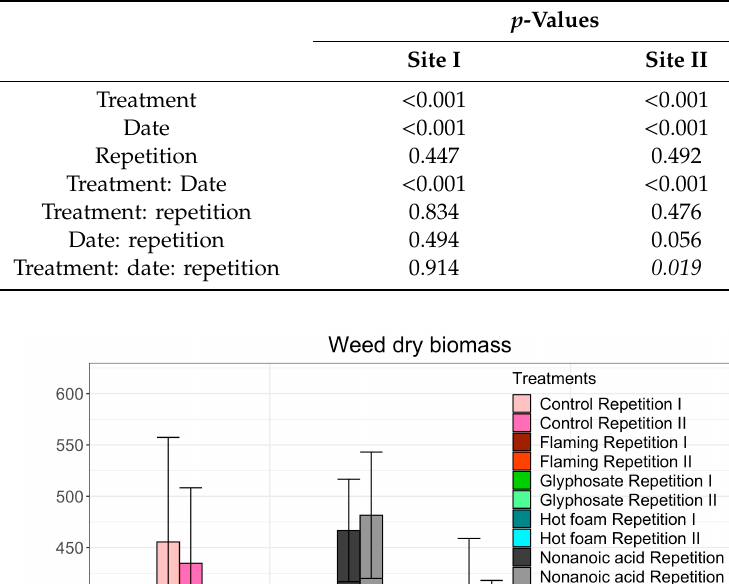
Table 4. Weed regrowth analysis of variance resulting from the linear model, where weed coverage was a ff ected by the treatments (control, flaming, glyphosate, hot foam, and nonanoic acid), the evaluation date (3, 7, 10, 13, 17 and 27 days after the treatments) and the repetition of the experiment (I and II) were used as factors. Significant p -values are shown in italics.